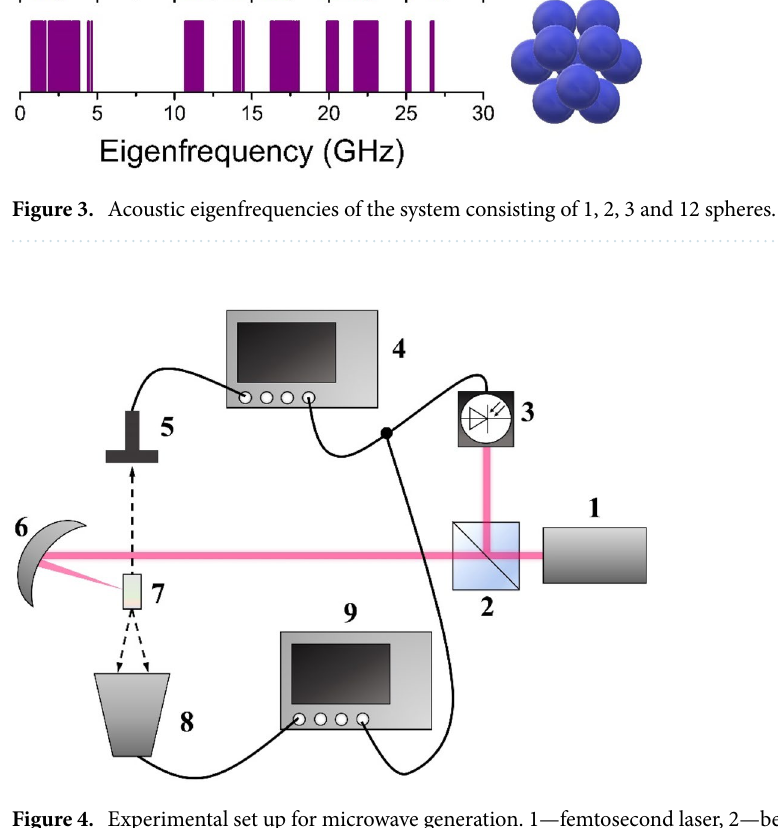
Figure 4. Experimental set up for microwave generation. 1—femtosecond laser, 2—beam splitter, 3— photodiode, 4—oscilloscope, 5—spiral antenna, 6—parabolic mirror, 7—opal sample, 8—wideband horn antenna, 9—spectrum